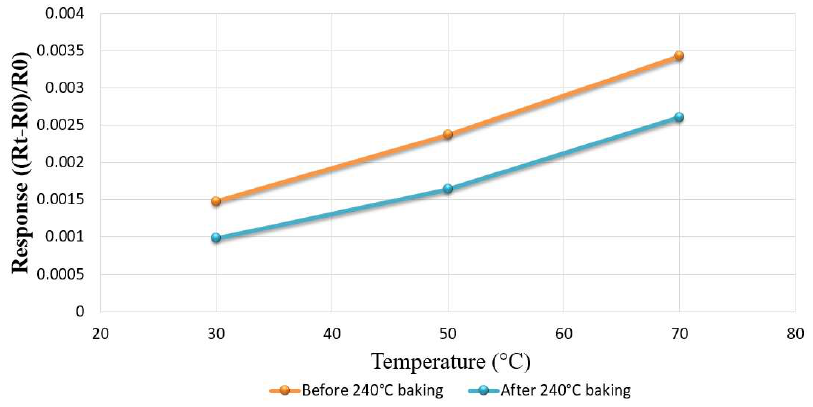
Figure 5. Comparison of the surface sensitivity of the hydrogen microsensor before and after bak- ing.